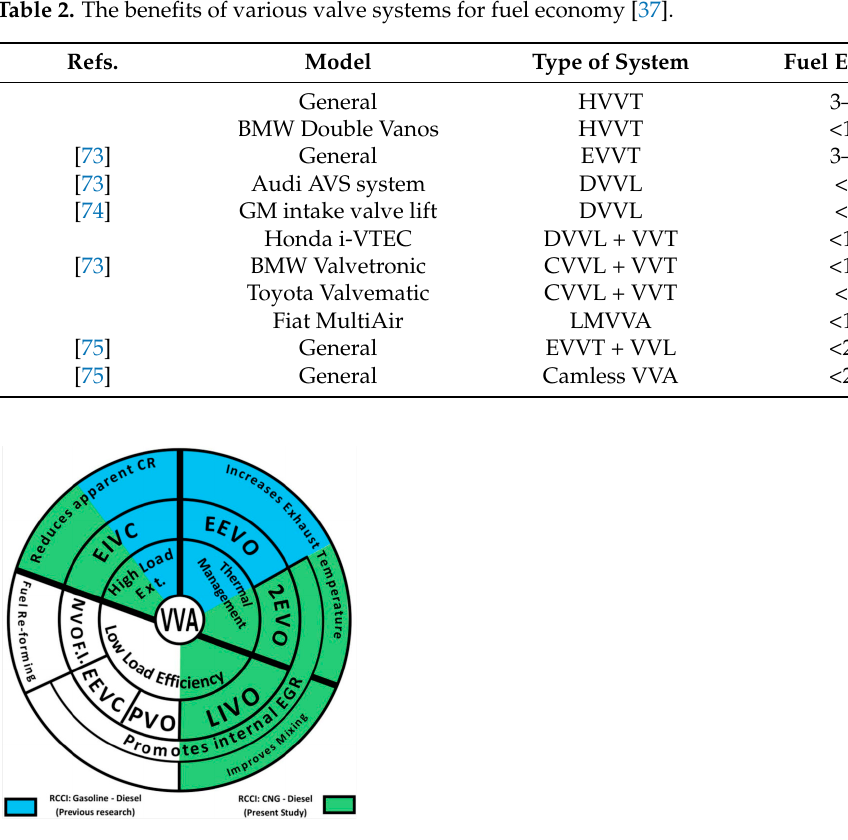
Figure 4. Principle and category of the VVA strategies in internal combustion engines [72]. Table 2. The benefits of various valve systems for fuel economy [37].